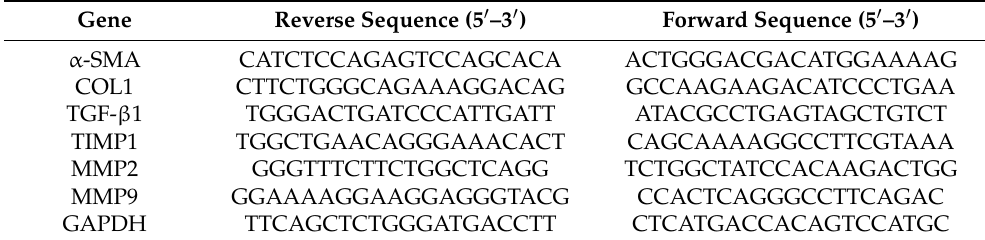
Table 2. List of primer sequences for qPCR